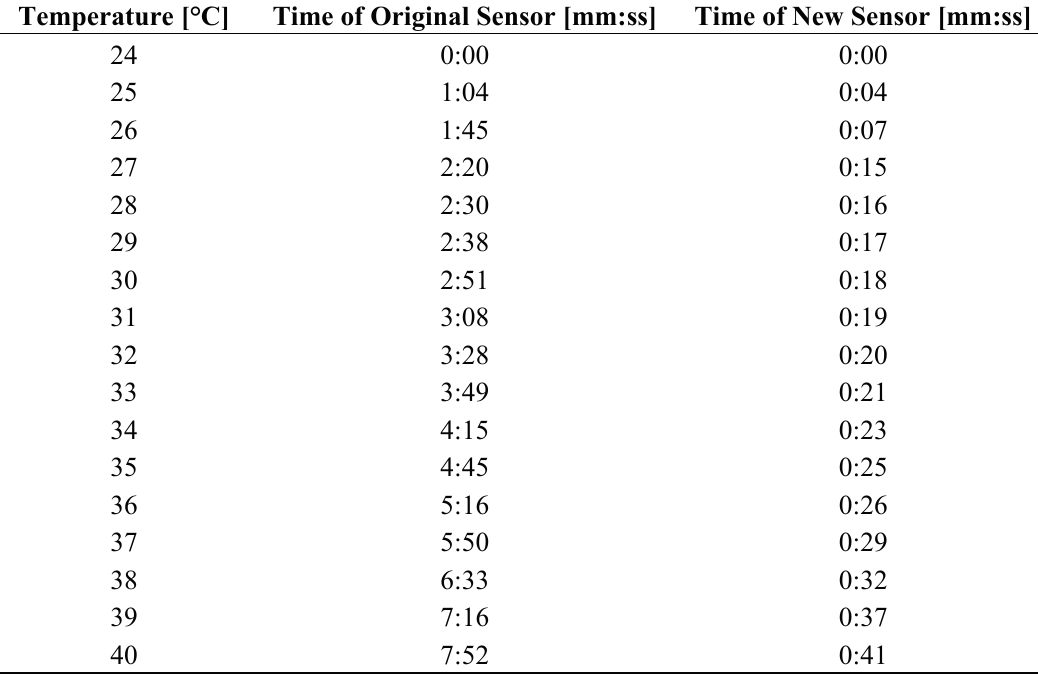
Table 5. Time delay of the sensors when the temperature is